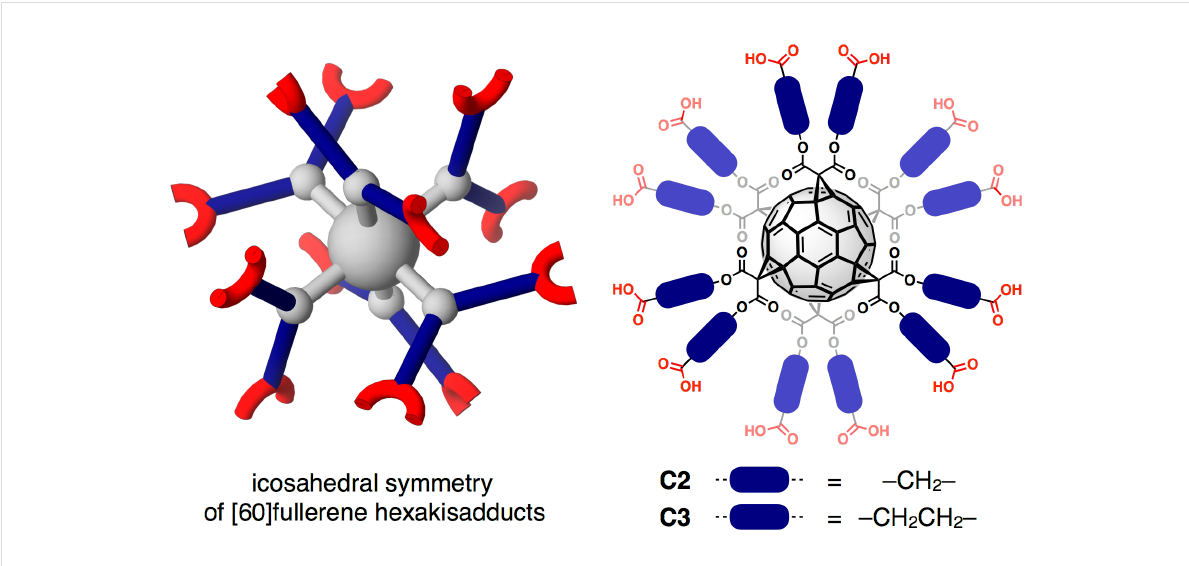
Figure 1: Icosahedral arrangement of functional addends for [60]fullerene hexakisadducts with dodecaacids C2 and C3 as prototypical examples for such carbon